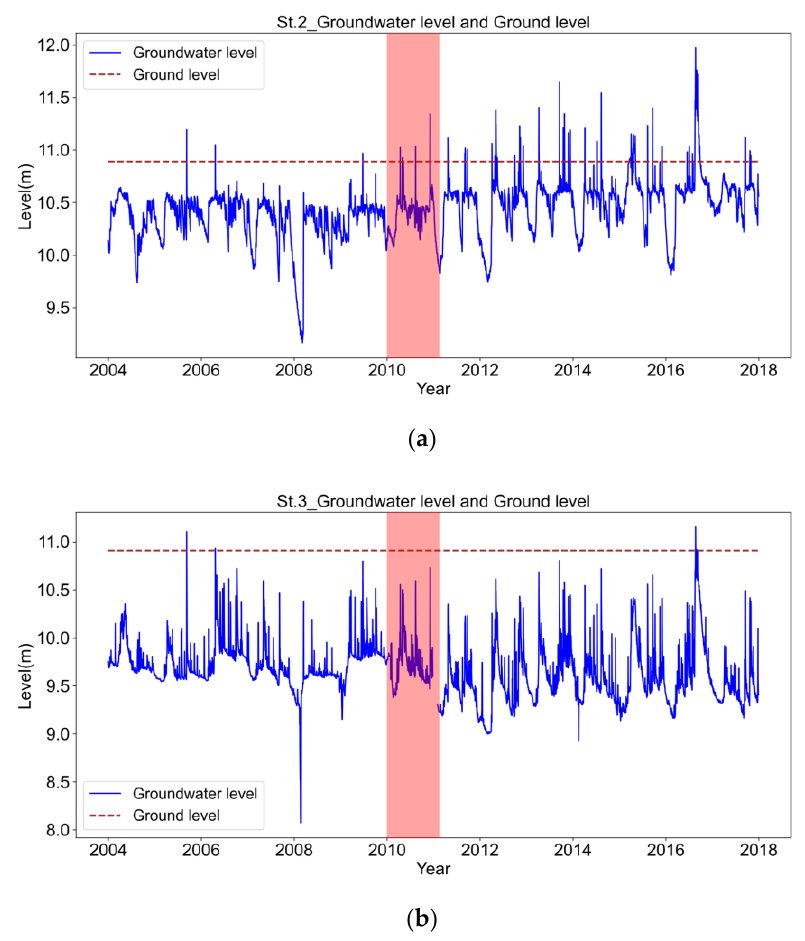
Figure 4. Groundwater level time series at observation points in the study site of Kushiro Wetland from 2004 to 2018: ( a ) St.2; ( b ) St.3. The red background color indicates the period of the channel restoration.